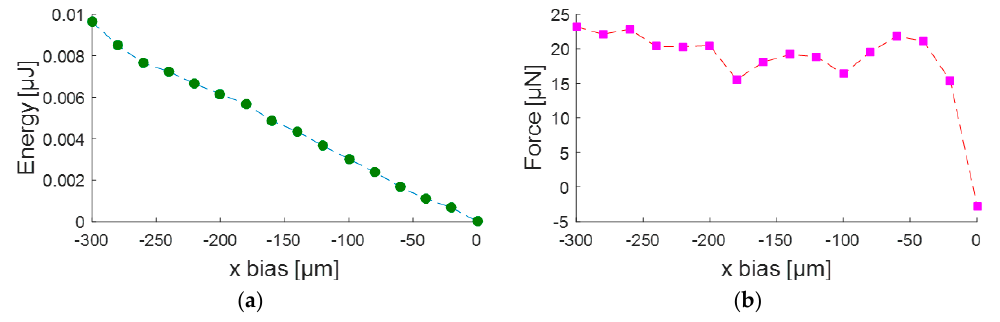
Figure 6. Surface energy ( a ) and restoring force ( b ) as a function of x bias.